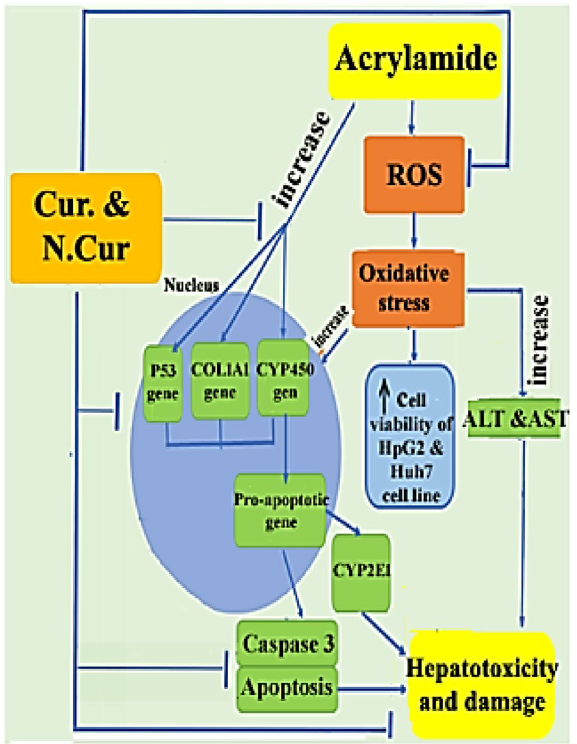
Figure 11. Graphical abstract shows the potential protection Cur. and N.Cur against acrylamide-induced toxicity, and oxidative stress via histopathological, biomarker, and molecular mechanism of some proteins in liver. Additionally demonstrates its cytotoxicity efficiency against HepG2 and Huh7 cell